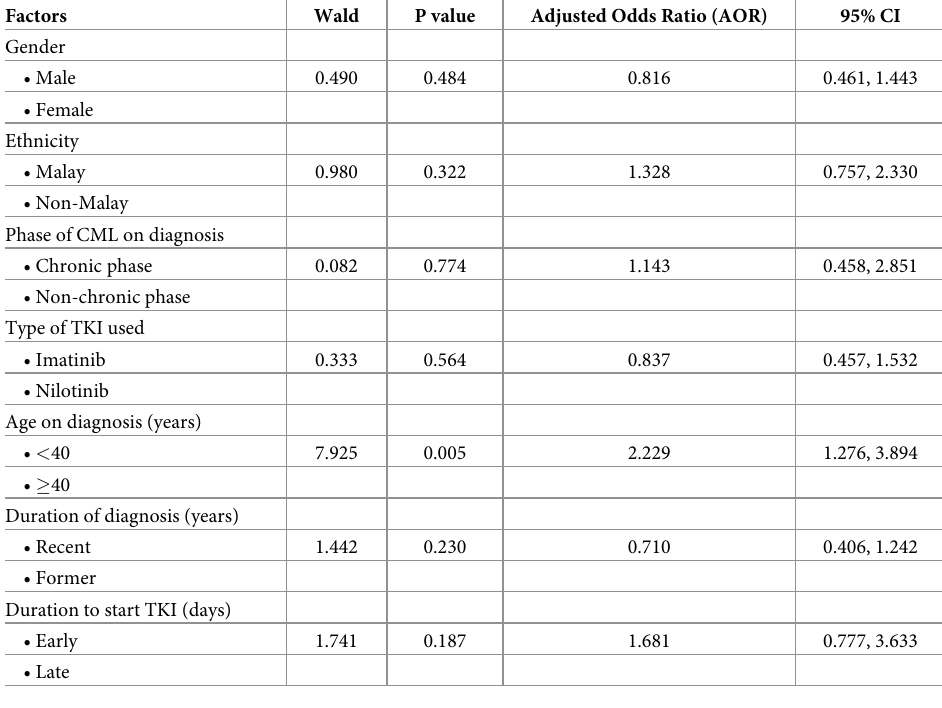
Table 5. Binary logistic regression analysis for determinants of CML health status by visual analogue